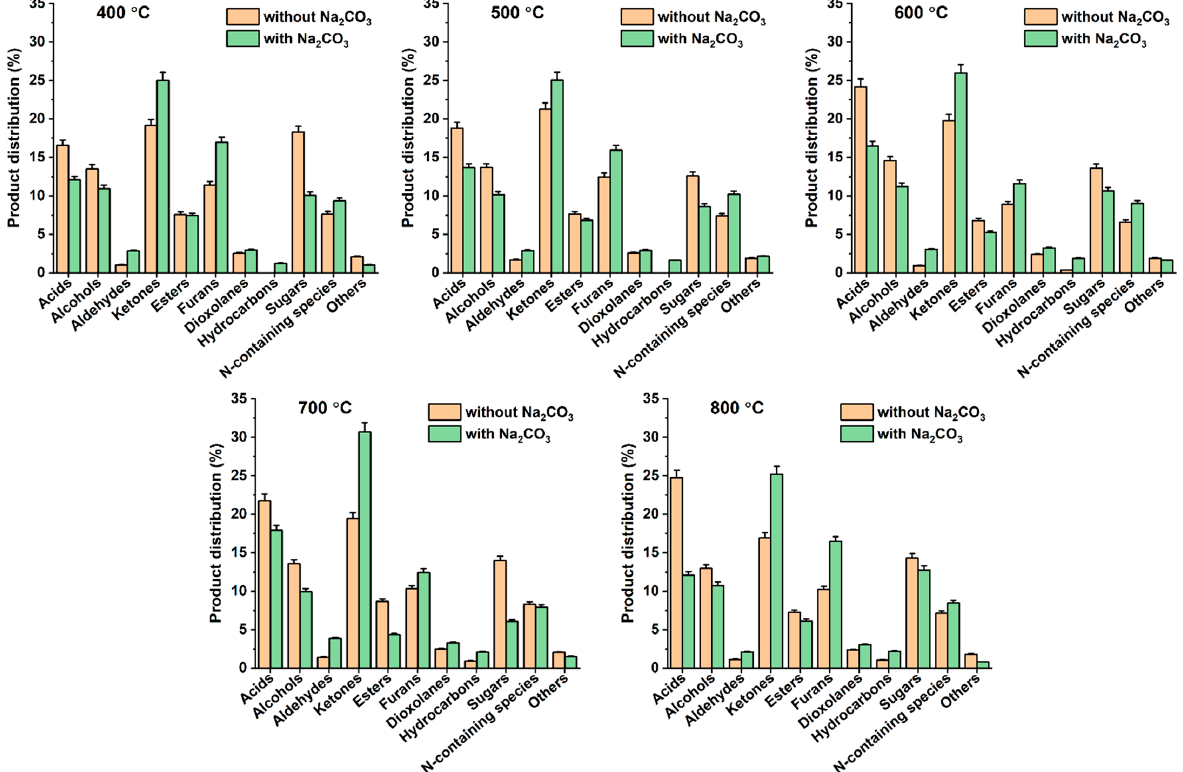
Figure 5. Product distributions of the liquid phase pyrolysates of DJW with and without Na 2 CO 3 at varied pyrolysis temperatures. Average values of triplicate are reported with standard deviations given as error bars.